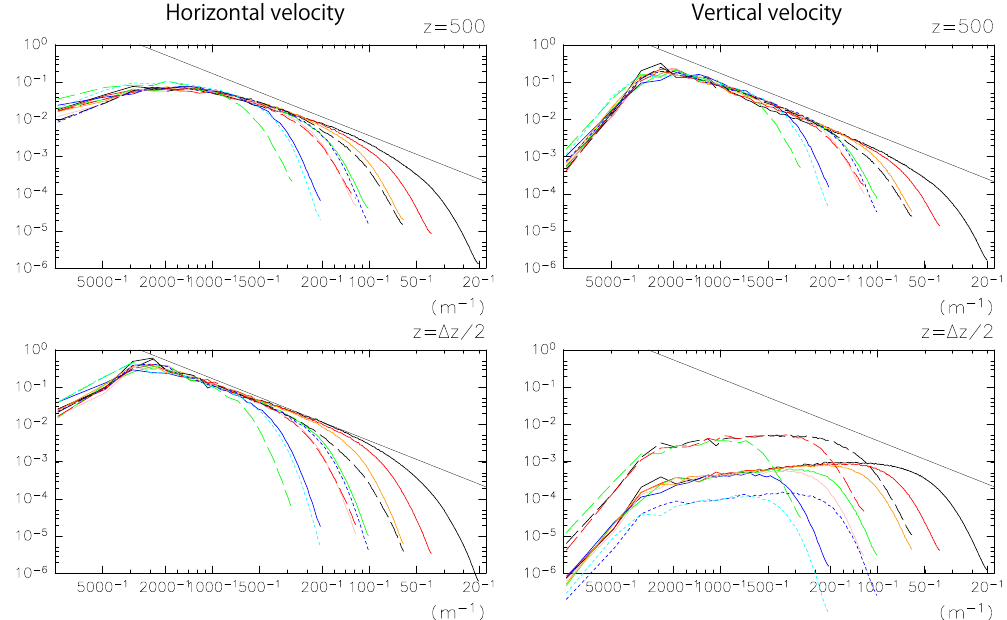
Figure 2. Same as Fig. 1, but spectrum of (left) horizontal and (right) vertical velocity at (top) height of 500m and (bottom) lowest layer ( z = 2 . 5, 5, and 15m for (cid:49)z = 5, 10, and 30m) in the control